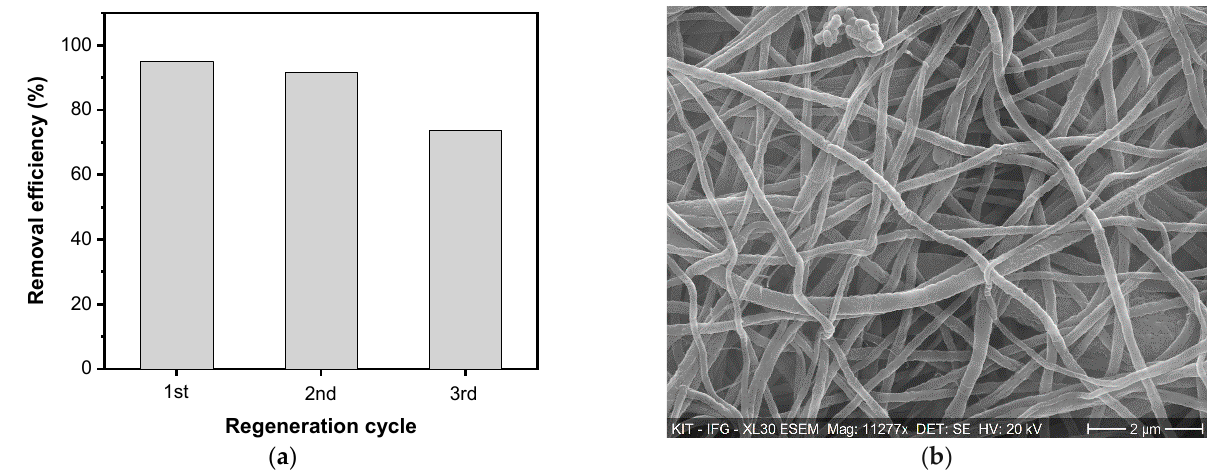
Figure 6. ( a ) Regeneration studies and ( b ) SEM image of CNM after various cycles (20 mg L − 1 , pH of 8, and at 60 min).